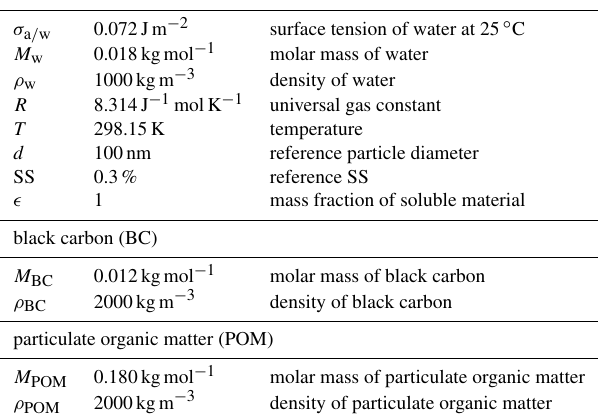
Table B1. Parameters and constants used for the calculation of the CCN activity of POM and BC